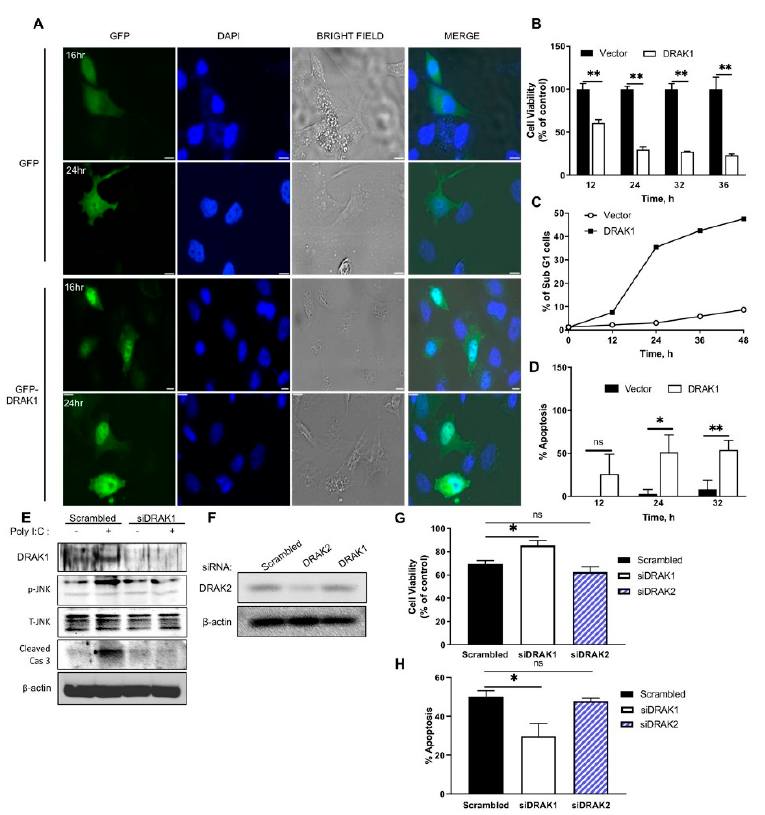
Figure 2. Nuclear localization of DRAK1 and induction of apoptosis ( A ) Fluorescence microscopy of DRAK-GFP or GFP vector expression and bright field images at indicated times in PC3 cells (scale bar, 10 µm, representative images are shown). PC3 cells were transfected with vector or DRAK1 construct and cell viability was determined at indicated times by ( B ) 3-(4,5-dimethylthiazol-2-yl)-2,5-diphenyltetrazolium bromide (MTT) assay and normalized to control, ( C ) uptake of Propidium Iodide (PI) by dying cells as measured by flow cytometry after staining with PI, ( D ) trypan blue dye exclusion assay normalized to control cells. Data shown as % apoptotic cells. PC3 cells were transfected with siRNA targeting DRAK1, DRAK2 or scrambled control siRNA and knock down and JNK phosphorylation and caspase 3 cleavage was determined on immunoblots following transfection with Poly I:C ( E , F ), and ( G , H ) cell viability was analyzed after transfection with 2–5A (10 µM) by MTT assay and % apoptotic cells was determined by trypan blue exclusion assay. Values shown are mean ± s.d of triplicate assays. * p < 0.01, ** p < 0.001, ns: not significant.